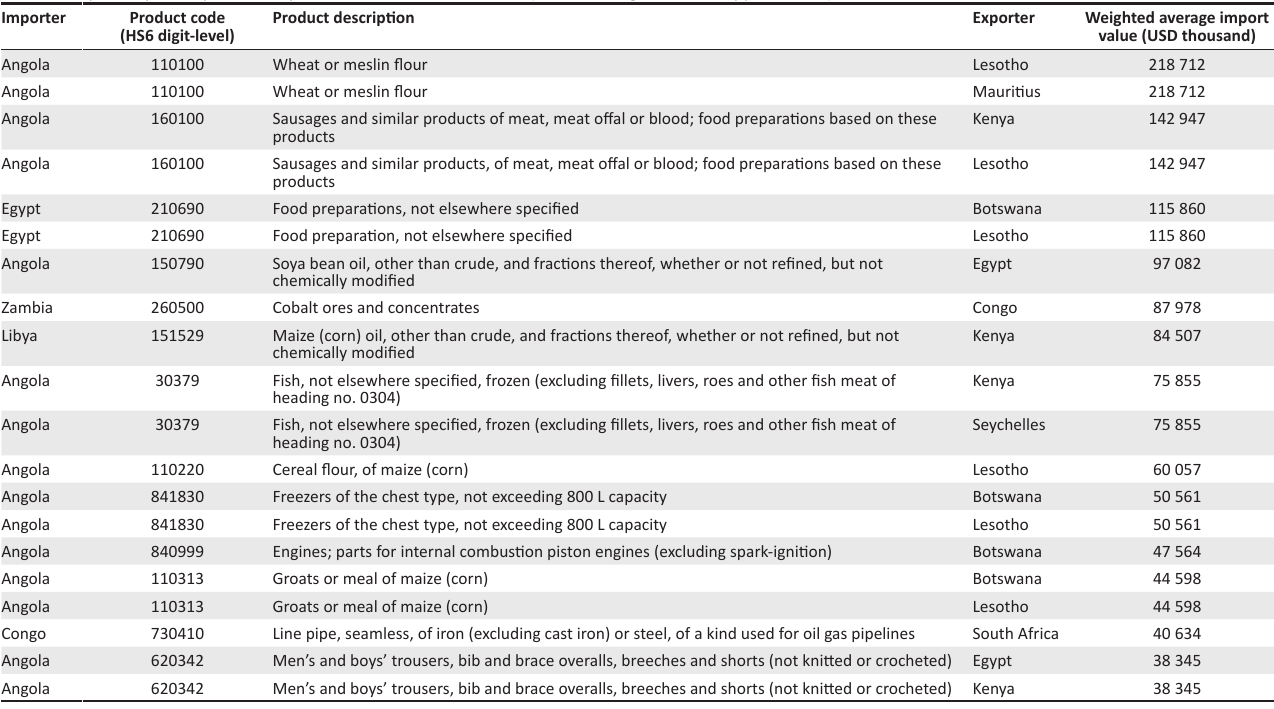
TABLE 8: Top 20 importer–product–exporter matches with zero trade (new intra-regional trade opportunities) 2010–2014. Importer Product code (HS6